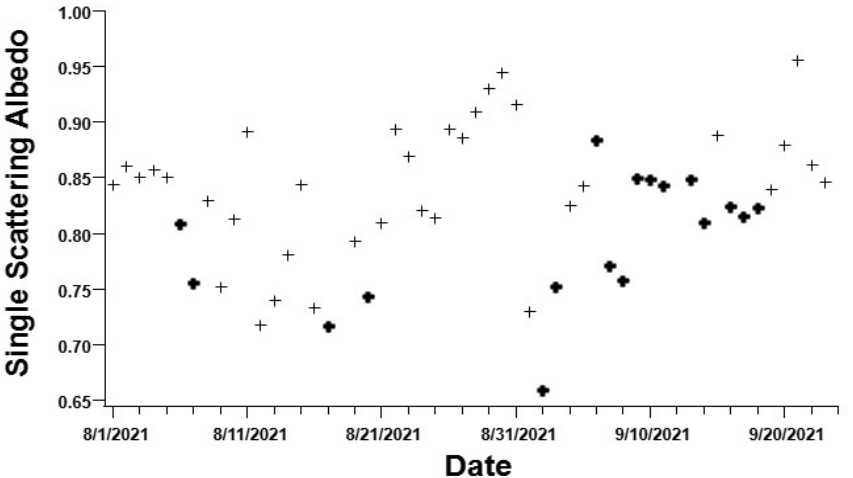
Figure 10. The Single Scattering Albedo (SSA) for September of 2021 was calculated using the PAX 870 instrument. The bold marking indicates the SSA of event days. Each point represents the average measurement for the day.